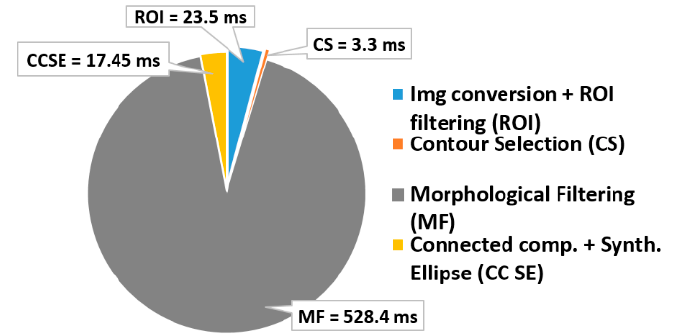
Figure 10. The time breakdown of the pure software execution of the geometrical inspection algorithm.